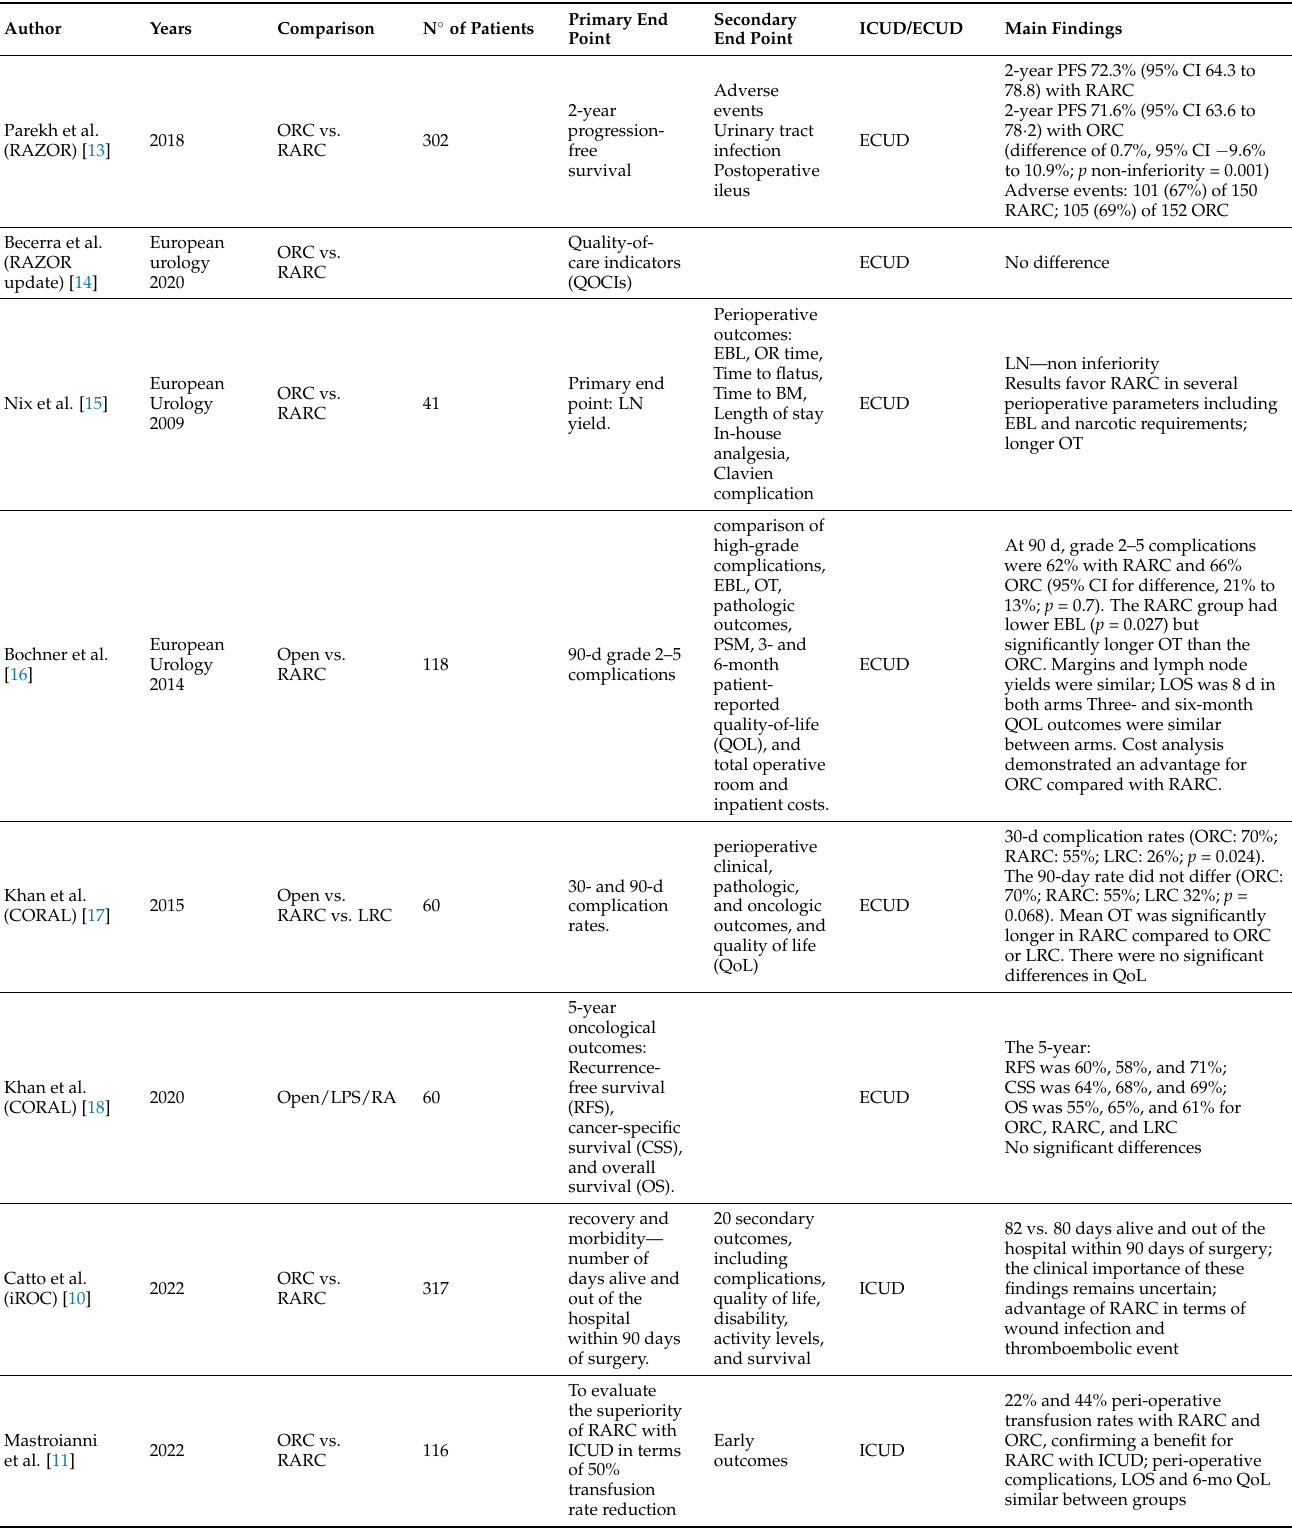
Table 3. Summary of findings from RCTs comparing surgical